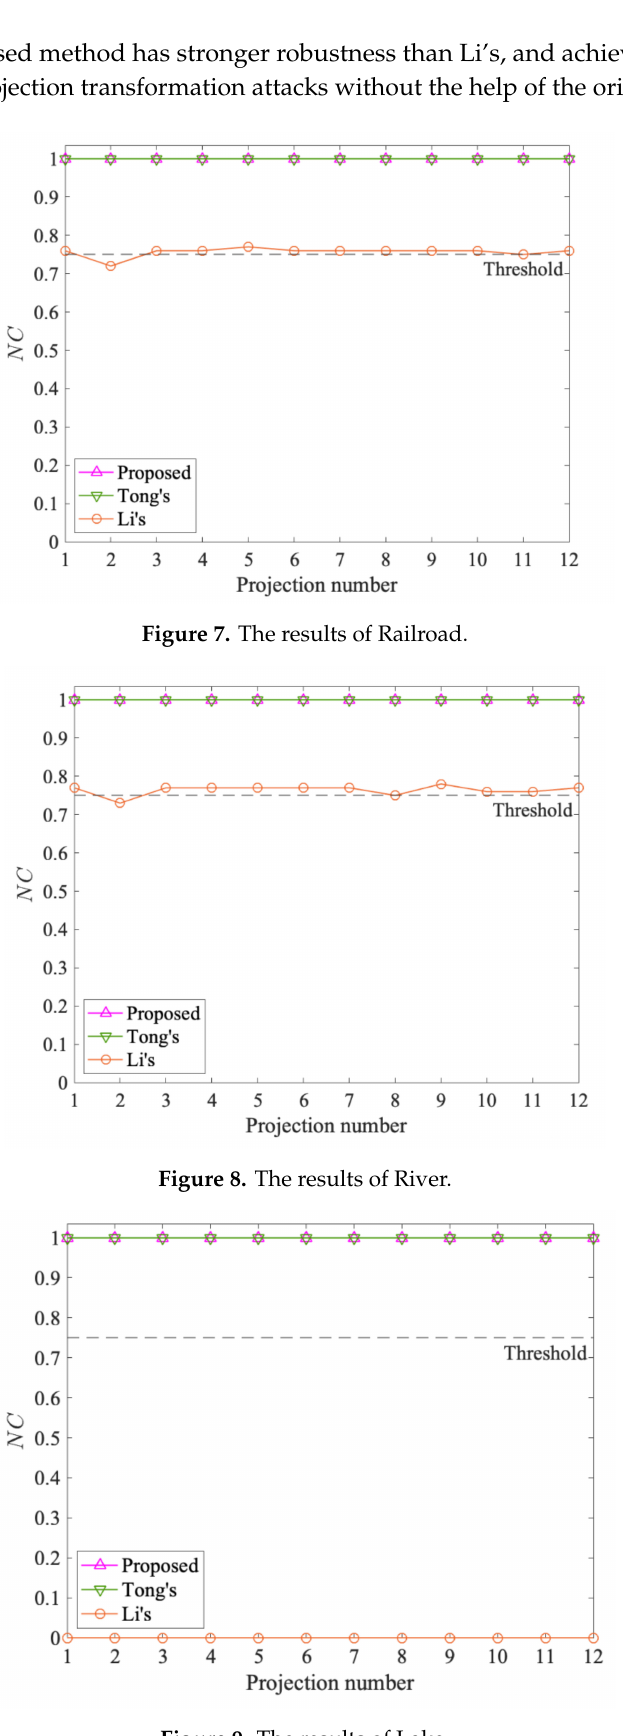
Figure 9. The results of